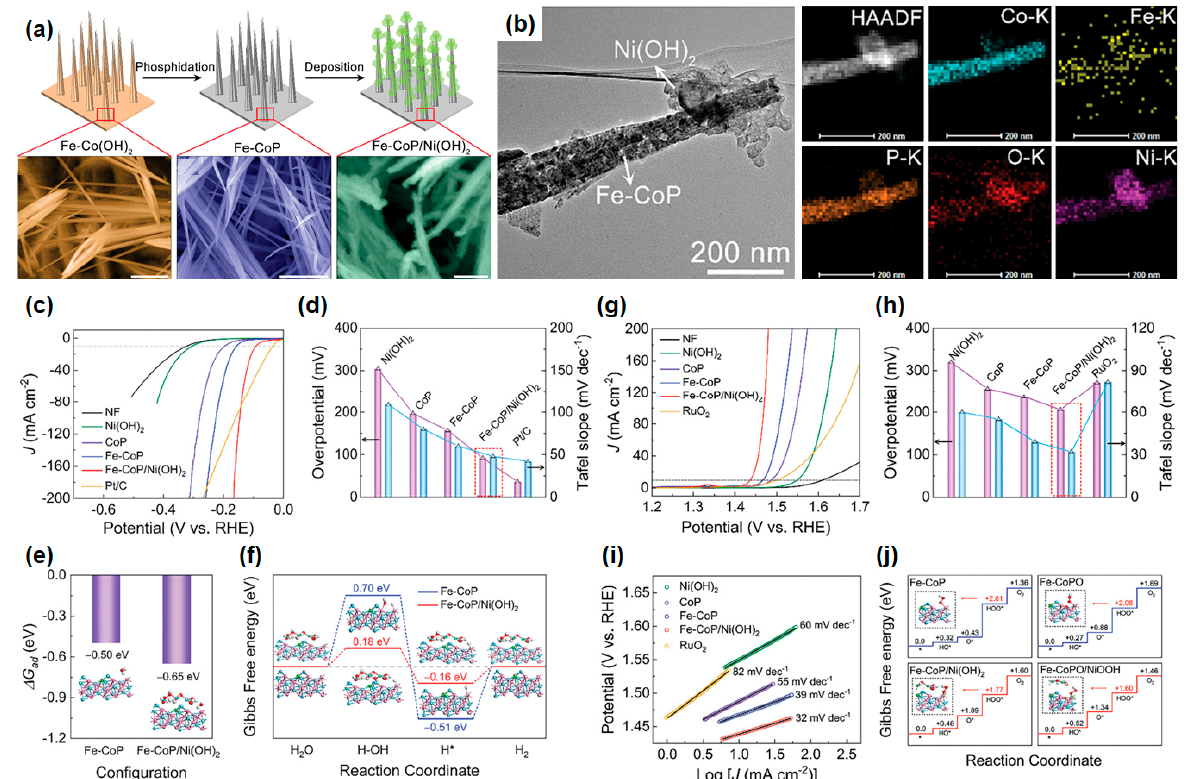
Figure 7. ( a ) Schematic illustration of the synthesis steps of the Fe-CoP/Ni(OH) 2 hybrid and SEM images of Fe-Co(OH) 2 , Fe-CoP, and Fe-CoP/Ni(OH) 2 nanowires. ( b ) TEM image, HAADF-STEM image, and EDS mapping images of the Fe-CoP/Ni(OH) 2 hybrid nanowire. ( c ) The iR-corrected LSV curves and ( d ) comparison of overpotential and Tafel slope at different electrodes for HER in 1 M KOH. ( e ) Comparison of calculated water adsorption energy ( ∆ Gad) and ( f ) calculated Gibbs free energy diagrams for alkaline HER at the bare Fe-CoP surface and the Fe-CoP/Ni(OH) 2 hybrid surface. ( g ) iR-corrected LSV curves, ( h ) Tafel plots, and ( i ) comparison of overpotential and Tafel slope at different electrodes for OER in 1 M KOH. ( j ) Calculated Gibbs free energy diagrams of the OER pathway at the Fe-CoP, Fe-CoP/Ni(OH) 2 , Fe-CoPO, and Fe-CoPO/NiOOH surfaces. Reprinted (adapted) from reference [151], copyright (2021) Wiley-VCH GmbH.